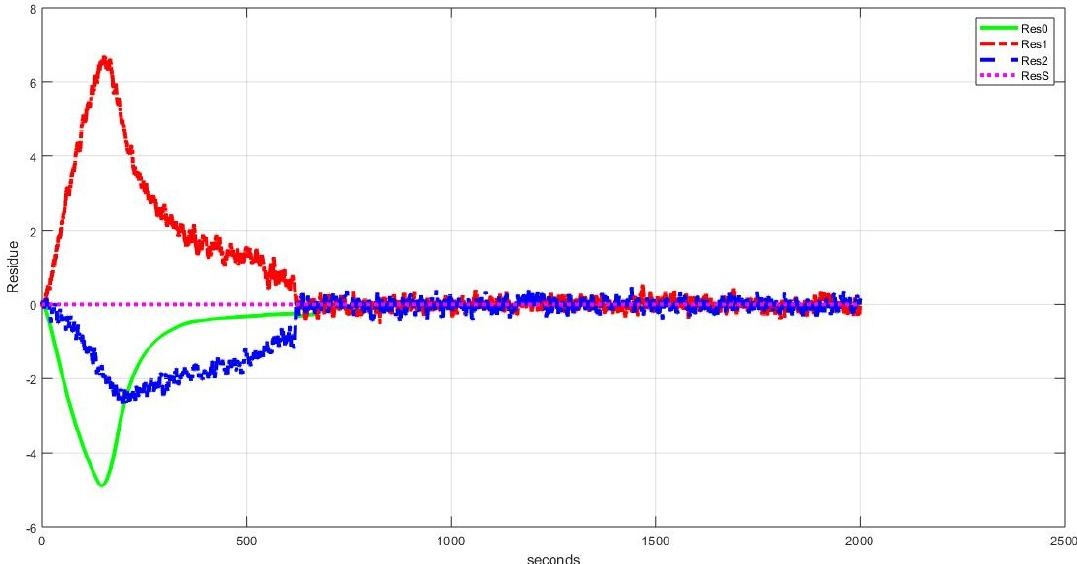
Figure 15. Pond residues for the saturation fault of the pond valve s 1 .